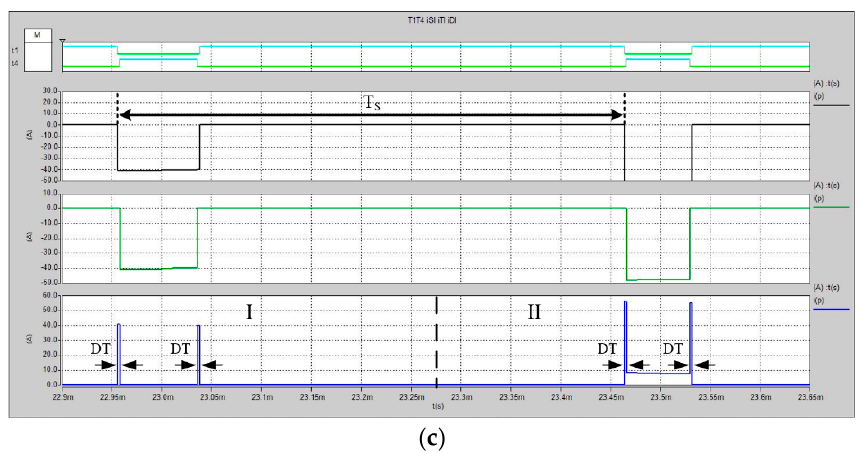
Figure 1. Three-phase inverter ( a ), typical waveforms of the MOSFET (metal–oxide–semiconductor field-effect transistor) and diode currents over one fundamental period ( b ) and the same waveforms illustrating a border between the first and second phase ( c ).